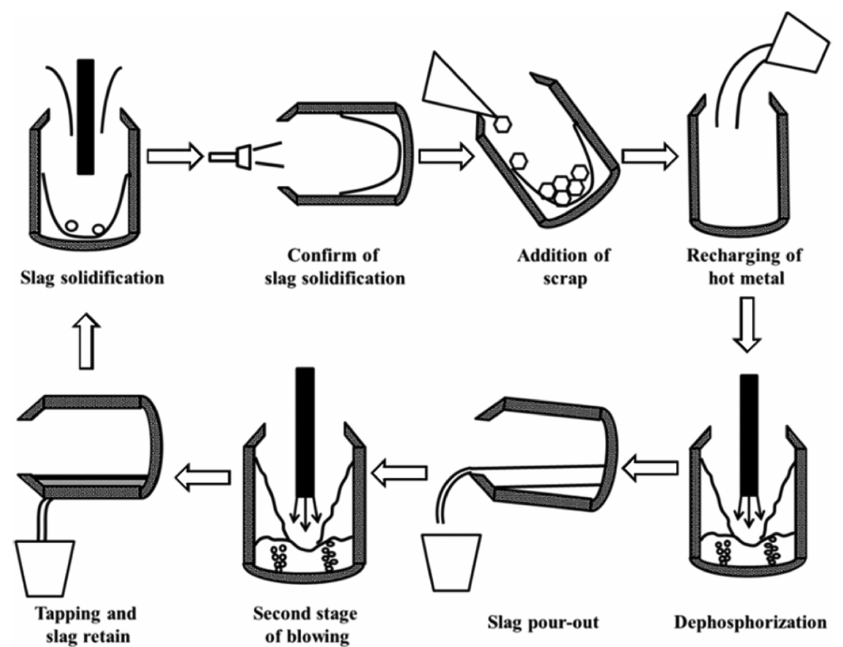
Figure 1: Schematic diagram of double- slag steelmaking process.